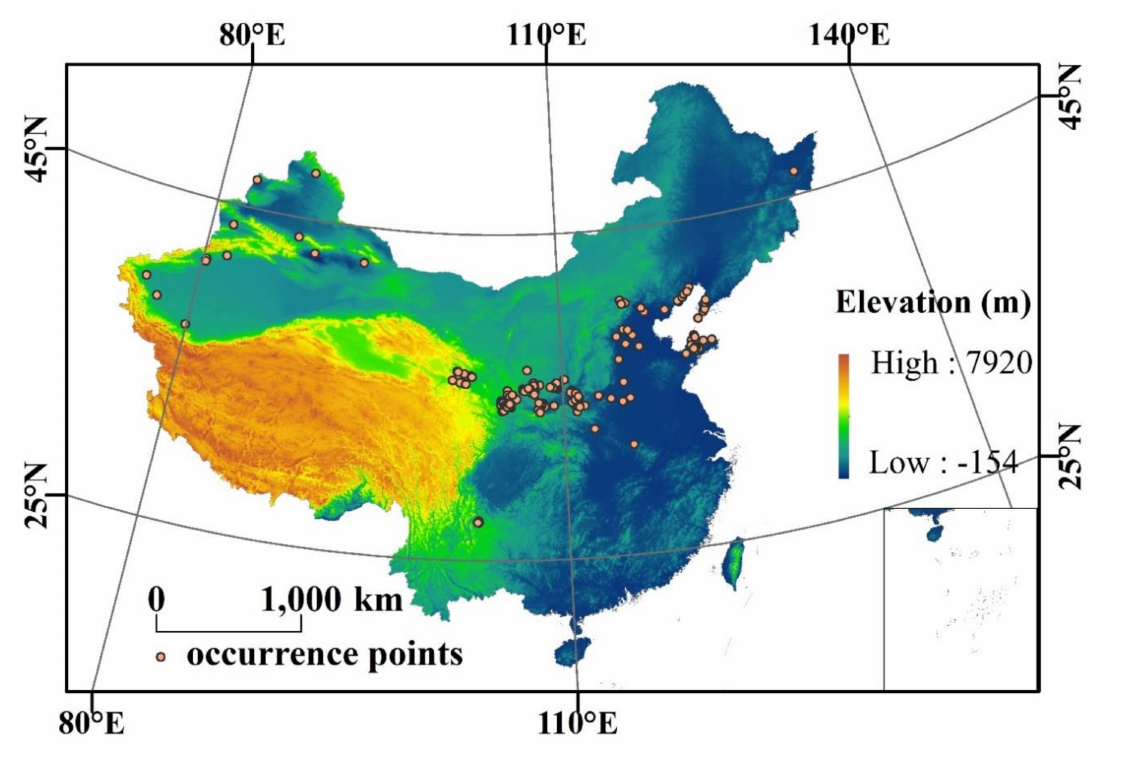
Figure 1. The occurrence data (158 points) of Valsa mali in